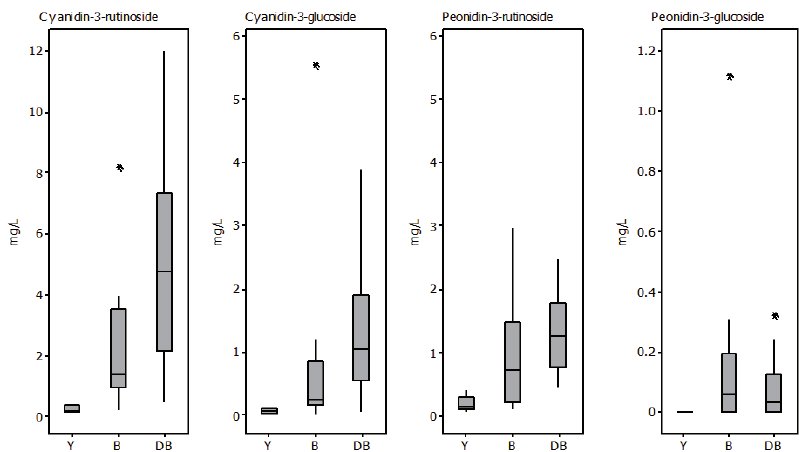
Fig. 3: Box plots of concentrations (mg/L) of individual anthocyanins in juices of plum varieties with blue (B), dark blue (DB) and yellow (Y)